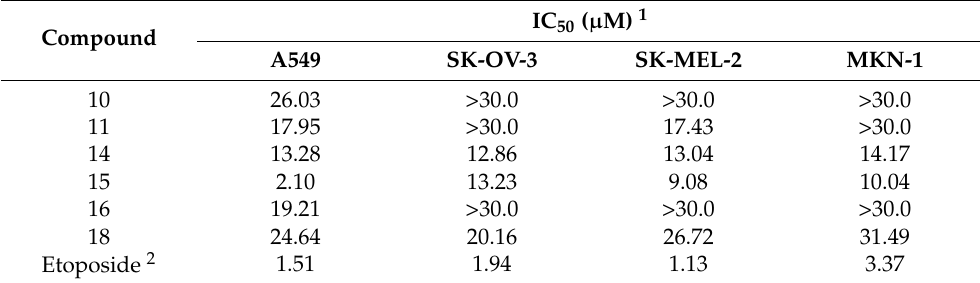
Table 3. Antiproliferative activities of selected compounds against four cultured human cell lines.